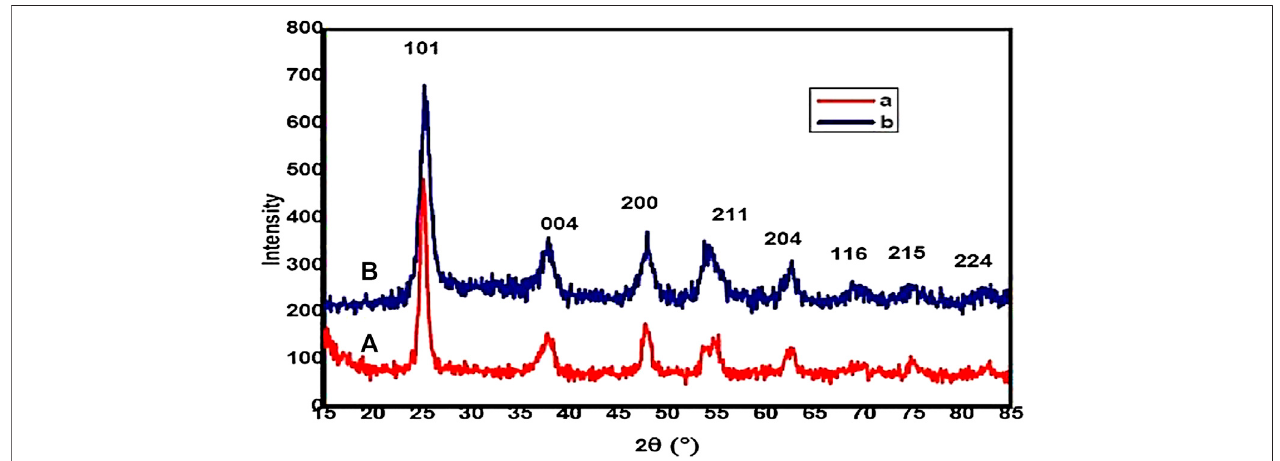
FIGURE 1 | XRD patterns of undoped TiO 2 (A) and 1 mmol of Fe – Ag co-doped TiO 2 NPs (B) .